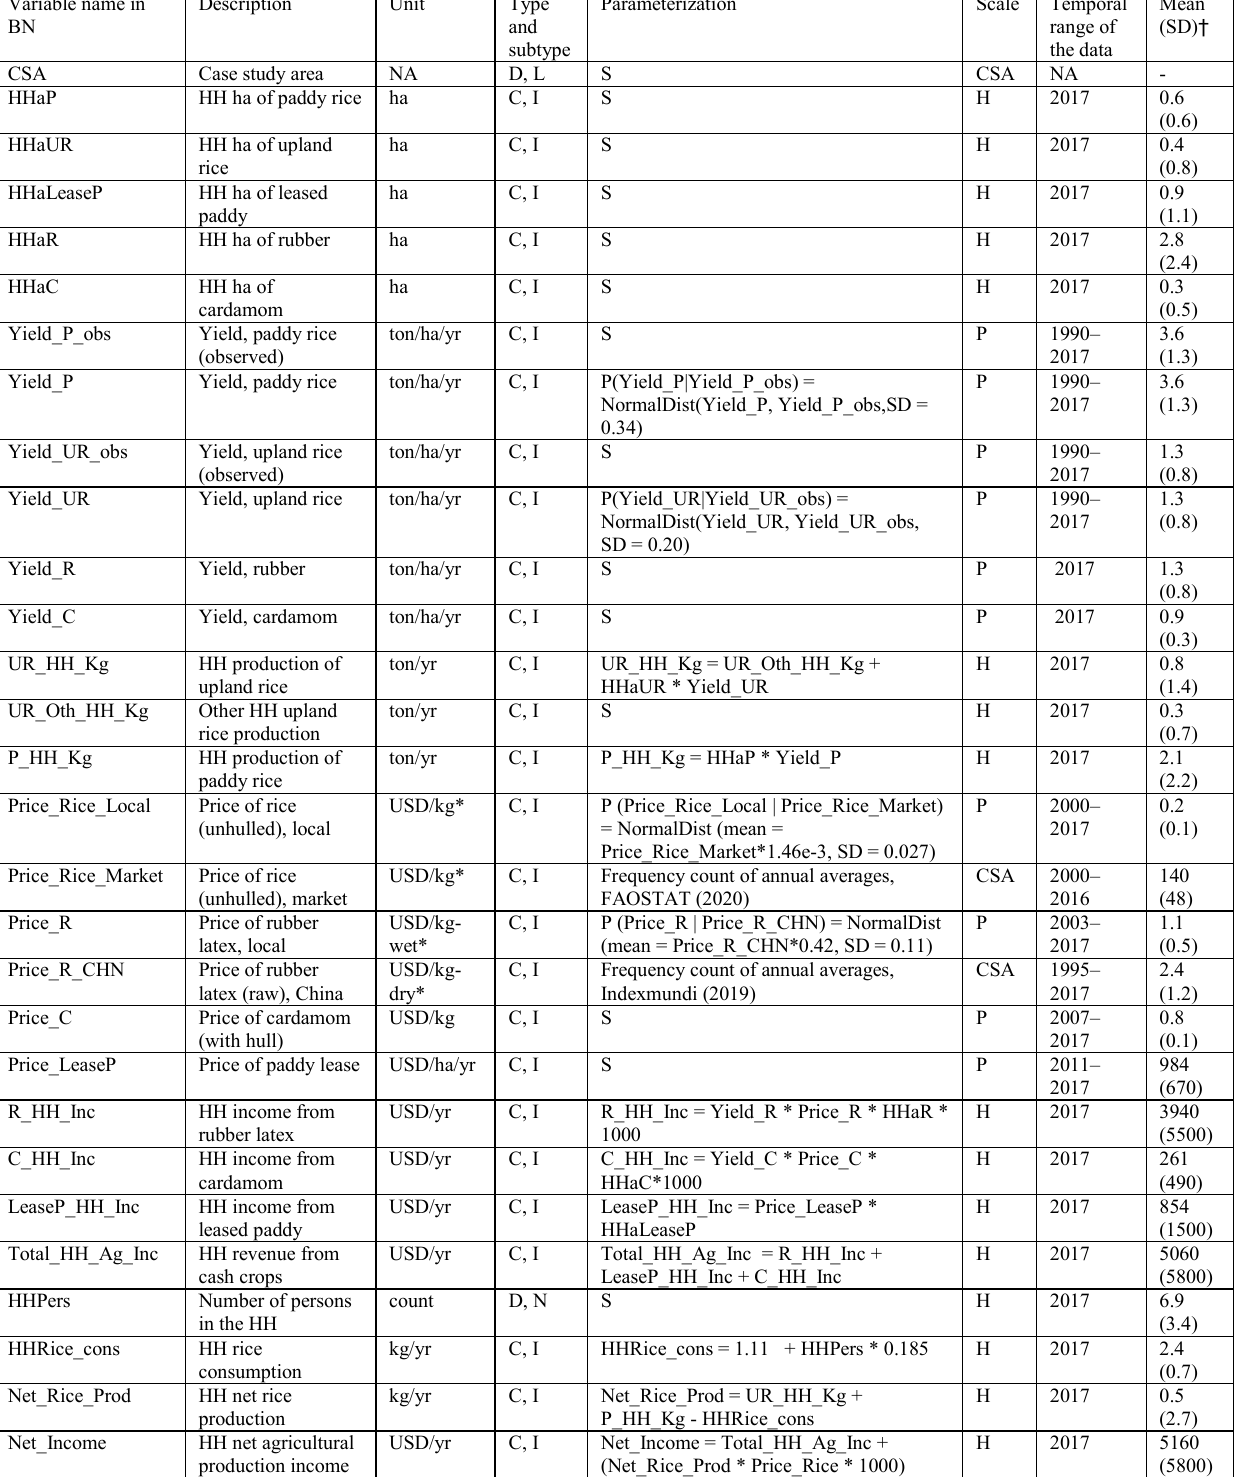
Table A1.2: Description of the variables in the BN and parameterization Variable name in